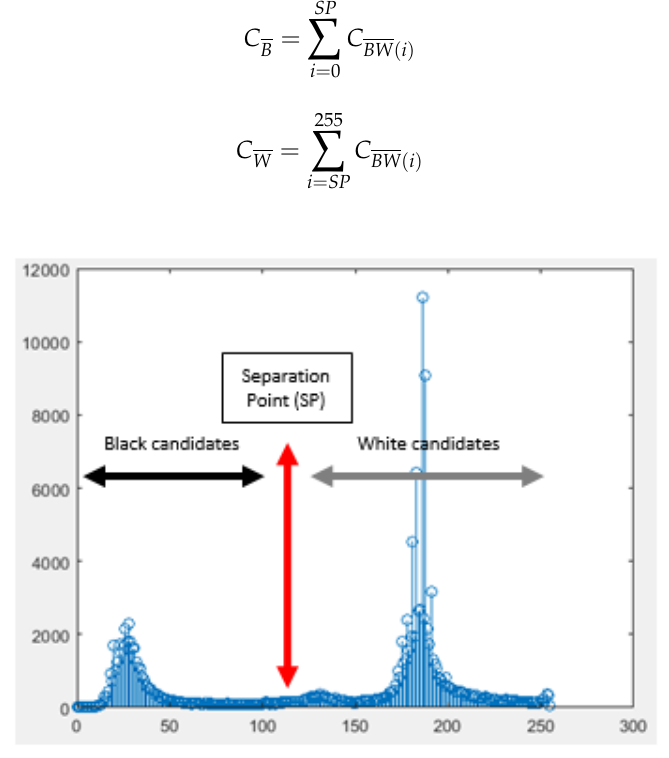
Figure 4. Black and white candidate’s histogram.